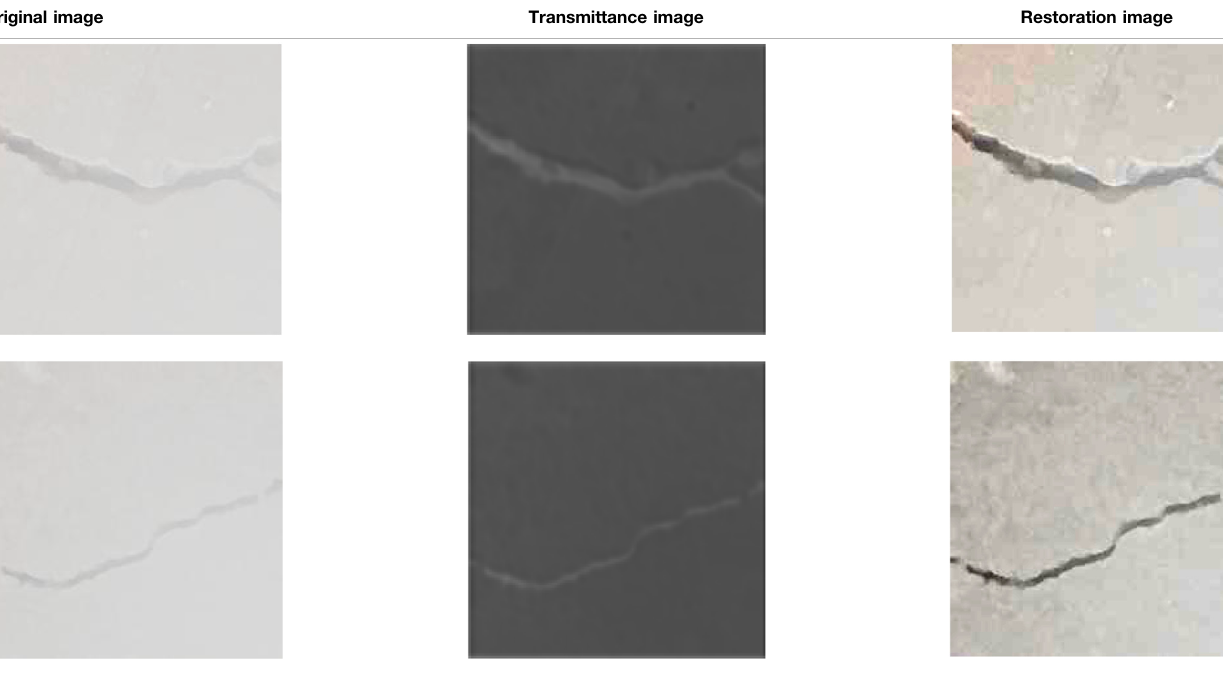
TABLE 7 | The haze removal results of the concrete surface cracks. Original